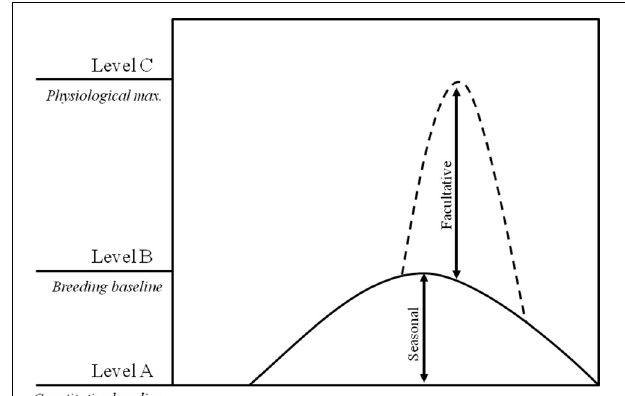
FIGURE 1 | Representation of the androgen changes proposed by the challenge hypothesis: (A) constitutive androgen levels; (B) breeding baseline levels needed for successful reproduction; and (C) maximum physiological